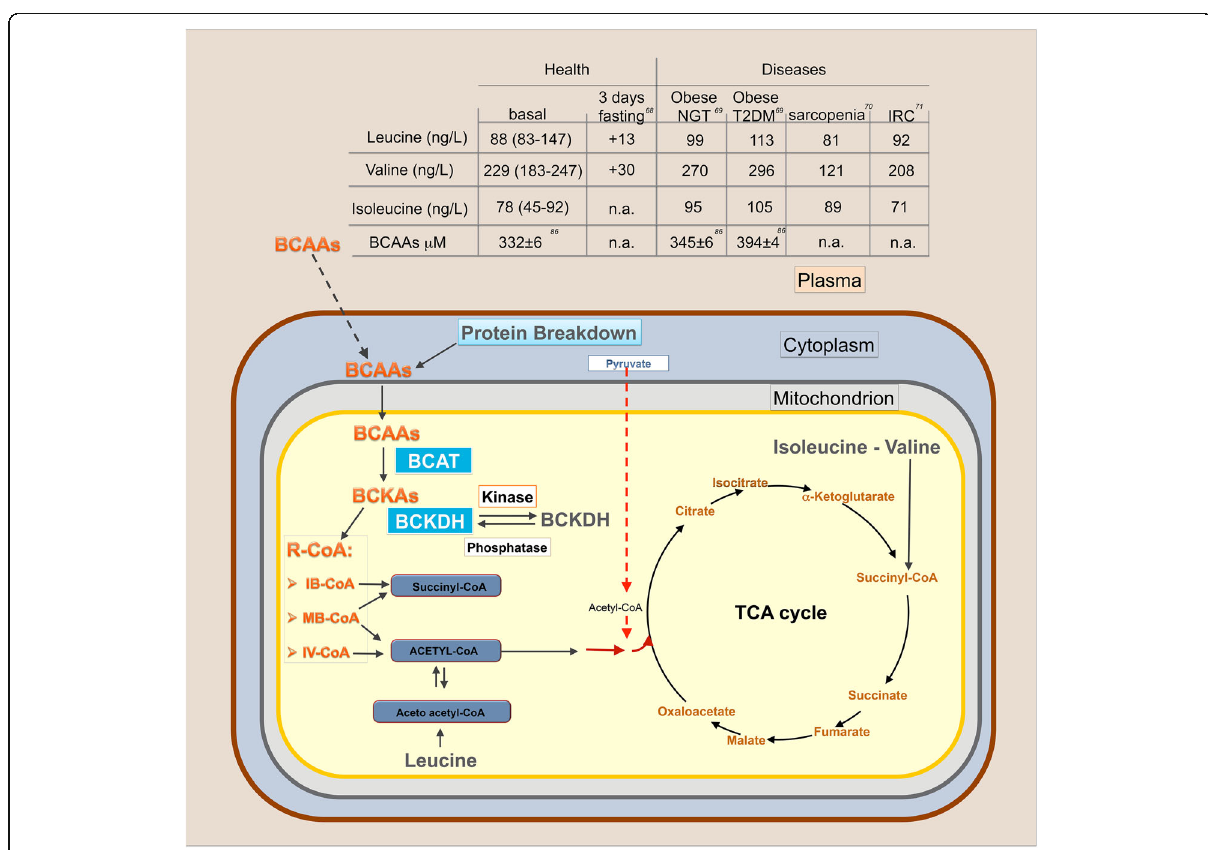
Fig. 2 Biochemistry of BCAAs. Plasma (brown), cytosolic (light blue) and mitochondrial (gray) compartments are depicted. Concentrations of branched-chain amino acids (BCAAs) in physiological and pathological conditions are reported in the table. BCAAs can both enter the cell from the plasma and be produced by protein breakdown. Intracellular BCAAs are transaminated in mitochondria by branched-chain aminotransferase (BCAT). The resulting branched-chain α -keto acids (BCKAs, especially α -keto acid from leucine) inhibit branched-chain α -keto acid dehydrogenase kinase, resulting in elevation of the active state of the rate limiting enzyme branched-chain α -keto acid dehydrogenase complex (BCKDH). BCAAs can be oxidized to generate ATP. Carbon originating from BCAAs enters the tricarboxylic acid (TCA) cycle as acetyl-CoA for complete disposal as CO 2 . Isoleucine and valine provide carbon for anaplerotic conversion of propionyl-CoA to succinyl-CoA. IB-CoA, isobutyryl-coenzyme A; IV-CoA, isovaleryl-coenzyme A; MB-CoA, α -methylbutyryl-coenzyme A; R-CoA, acyl-coenzyme